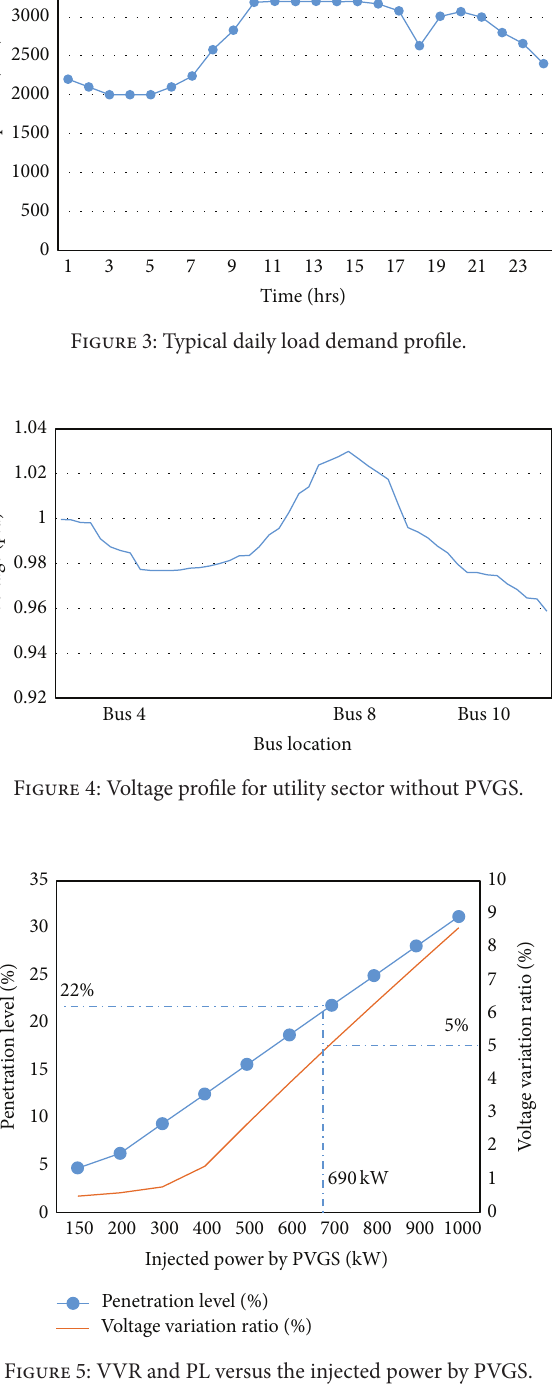
Figure 5: VVR and PL versus the injected power by PVGS.